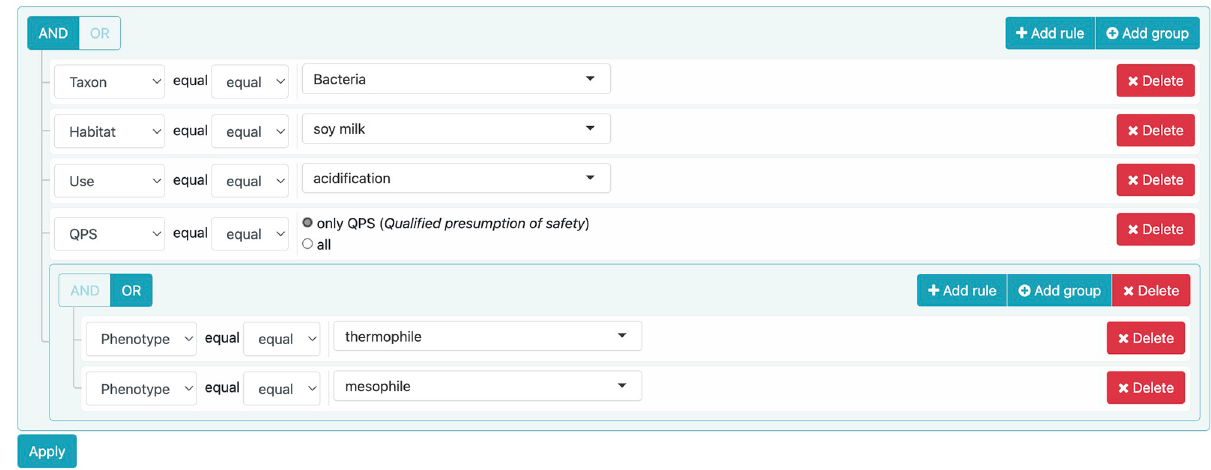
Fig 10. An example of complex embedded queries. These queries are used to retrieve mesophilic or thermophilic bacteria present in soy milk and capable of acidification, and with a qualified presumption of safety.